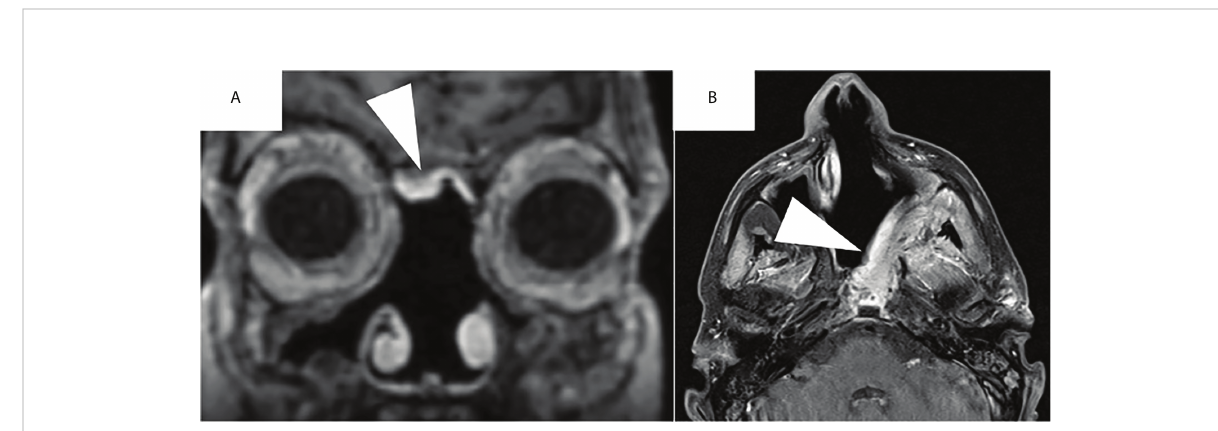
FIGURE 3 Post-operative aspect of a nasoseptal fl ap (A) and of a left super fi cial temporoparietal fascia fl ap (B) on contrast-enhanced T1-weighted MRI sequences. Note the hyperintense aspect of the fl aps after contrast enhancement (white